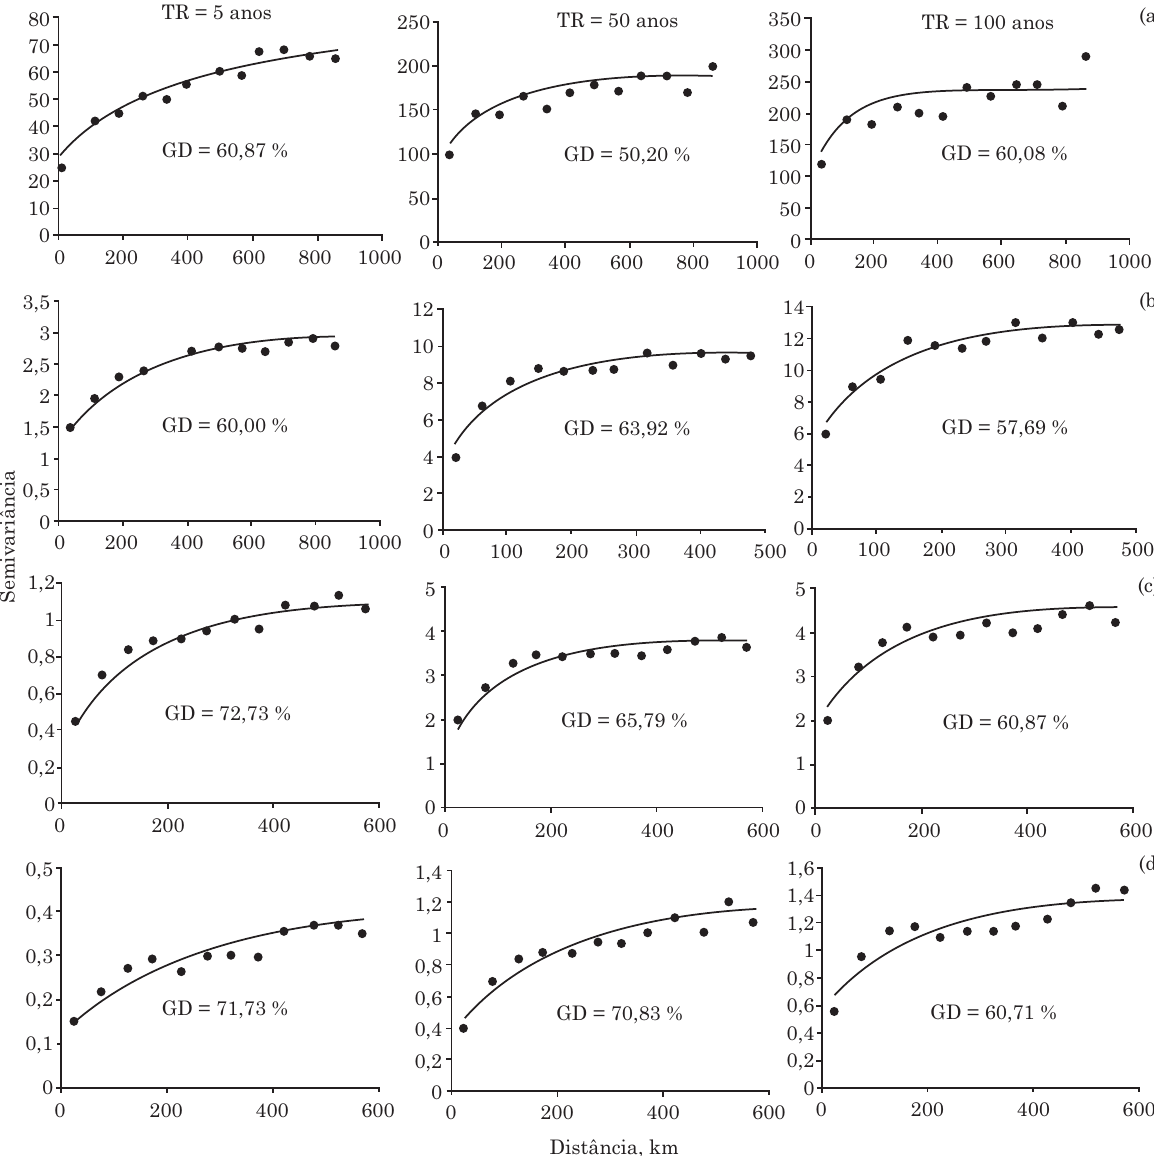
Figura 2. Semivariogramas cruzados ajustados para cada uma das situações de chuvas intensas analisadas no Estado de Minas Gerais: (a) 30 min de duração; (b) 360 min; (c) 720 min; e (d) 1.440